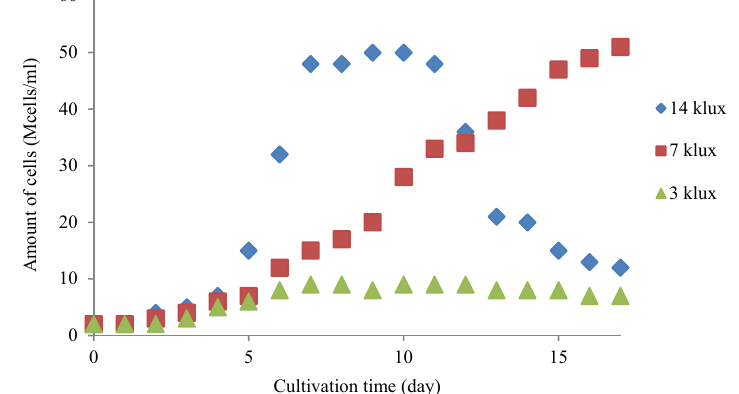
Fig. 4: Growth of biomass at different levels of lighting (Lv et al ., 2010)